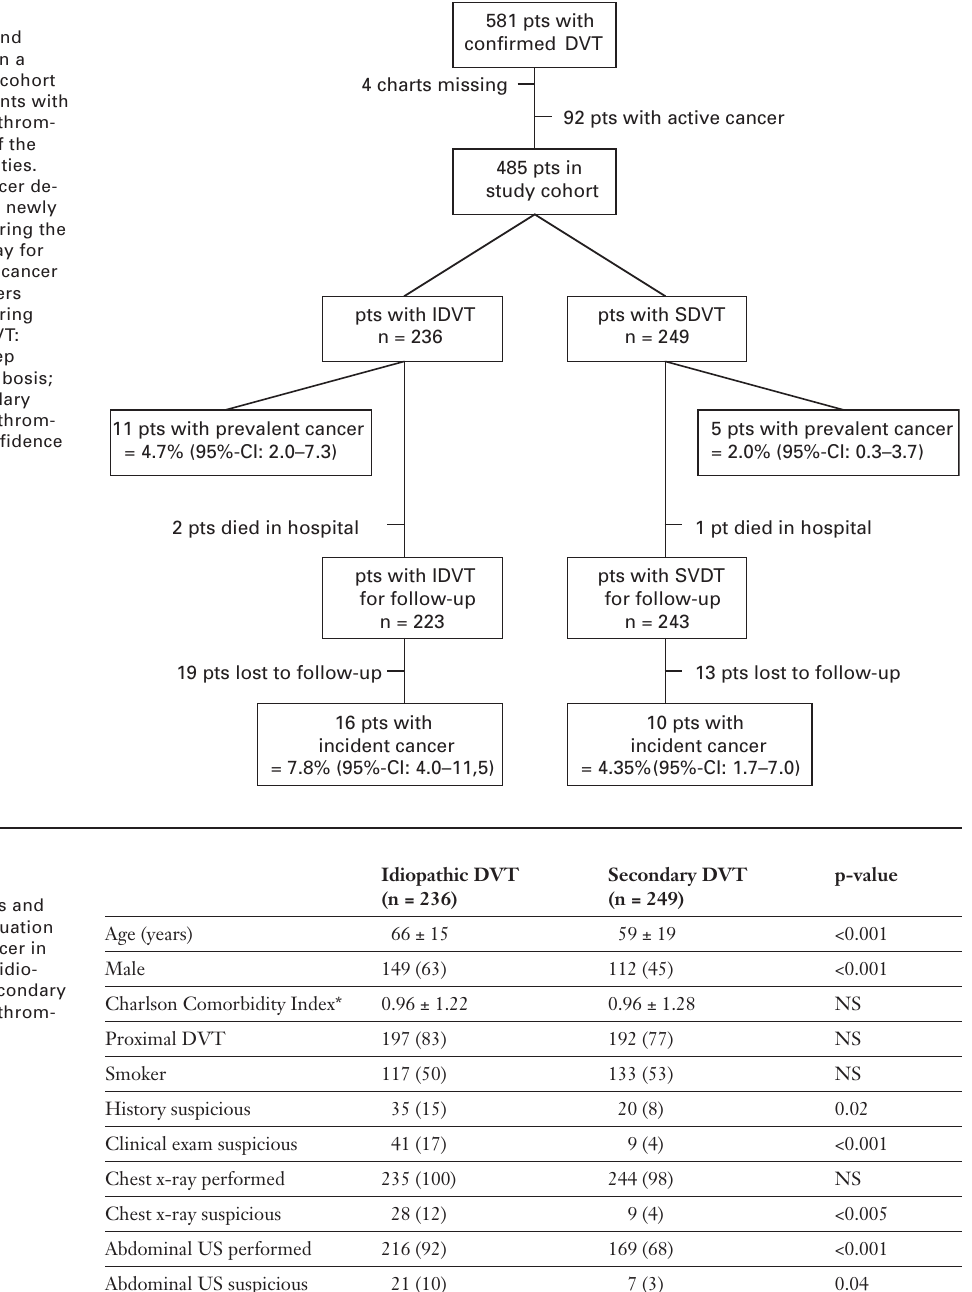
Patient flow and main results in a retrospective cohort study of patients with deep venous throm- bosis (DVT) of the lower extremities. Prevalent cancer de- notes cancers newly diagnosed during the in-hospital stay for DVT. Incident cancer denotes cancers diagnosed during follow-up. IDVT: Idiopathic deep venous thrombosis; SDVT: Secondary deep venous throm- bosis; CI: Confidence interval.